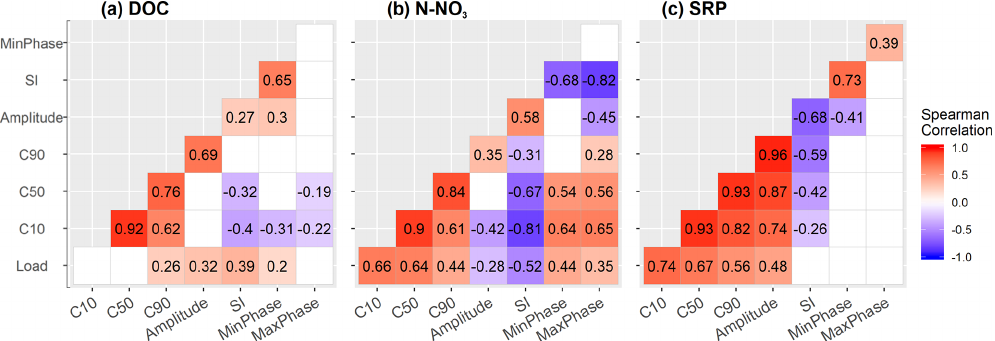
Figure 4. Matrices of Spearman’s rank correlations of water quality (load, concentration percentiles (10th ( C 10), 50th ( C 50), and 90th ( C 90)), and seasonality metrics) for (a) dissolved organic carbon (DOC), (b) nitrate N (N-NO 3 ), and (c) soluble reactive phosphorus (SRP) (c) . Only significant ( p ≤ 0 . 05) values are